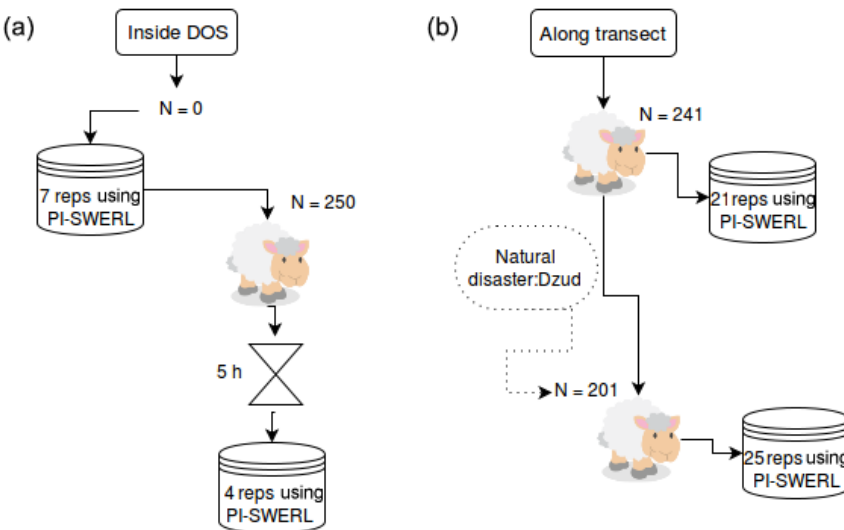
Figure 3. A schematic flowchart of the PI-SWERL ® experimental test (a) for zero trampling and trampling of N 250 inside the DOS and (b) for trampling of N 201 and N 241 along transect areas. PI-SWERL ® experimental replications for each dataset are marked as